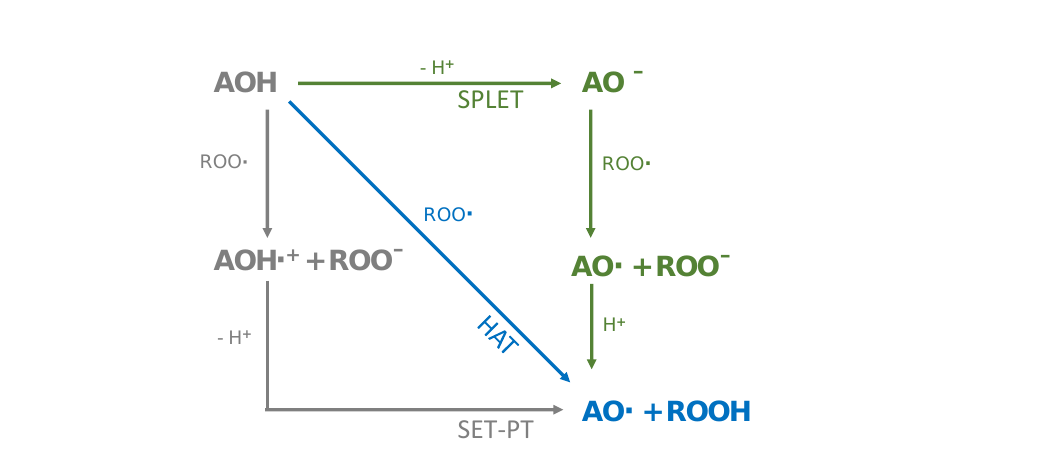
Figure 1. Schematic representation of HAT, single electron transfer followed by a proton transfer (SET-PT) and sequential proton loss electron transfer (SPLET) antioxidant reaction mechanisms (reproduced from Shang et al. (2009) [13] with some